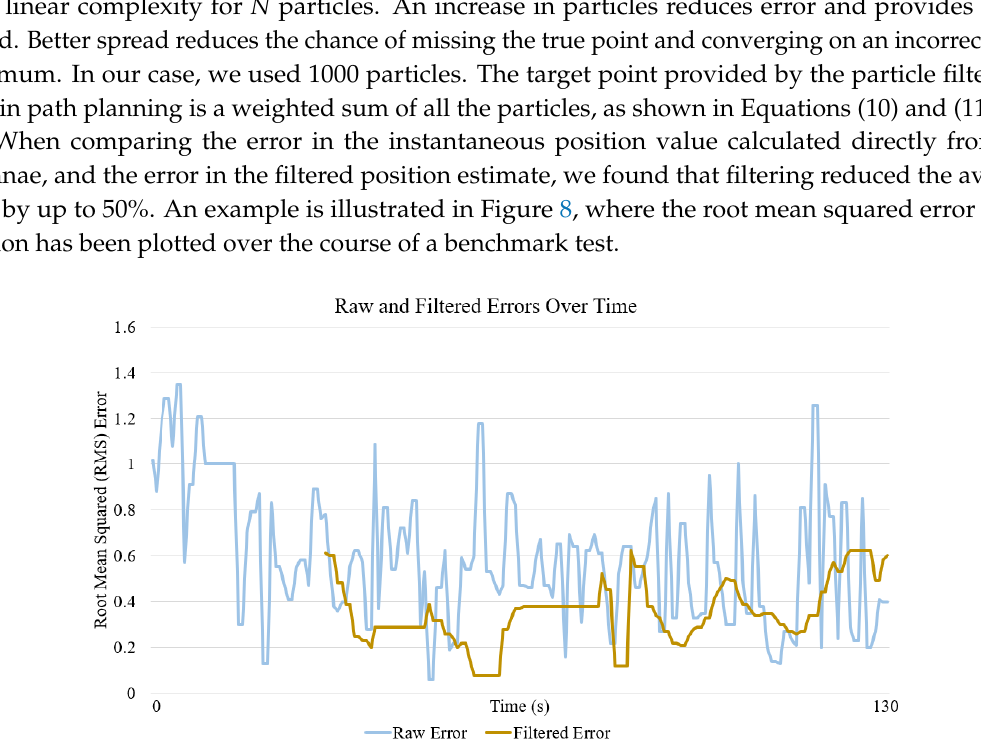
Figure 8. Raw and filtered errors over the course of a benchmark test.